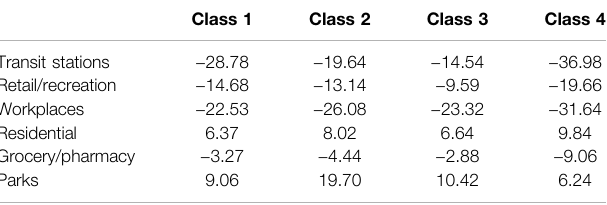
TABLE 15 | Means for mobility change variables by latent class.